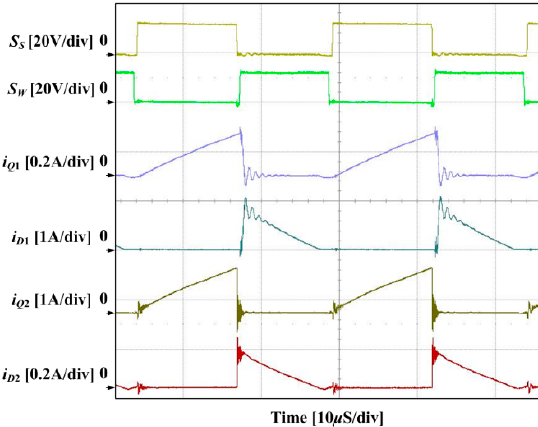
Figure 8. Operational waveforms of the proposed balancing circuit. Energies 2019 , 12 , x FOR PEER REVIEW